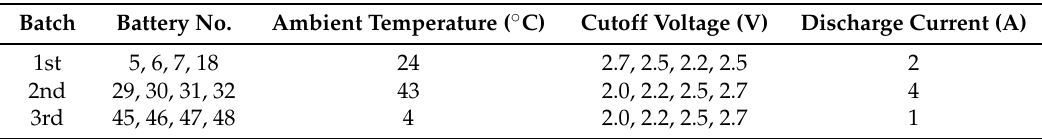
Table 3. Detailed information on data